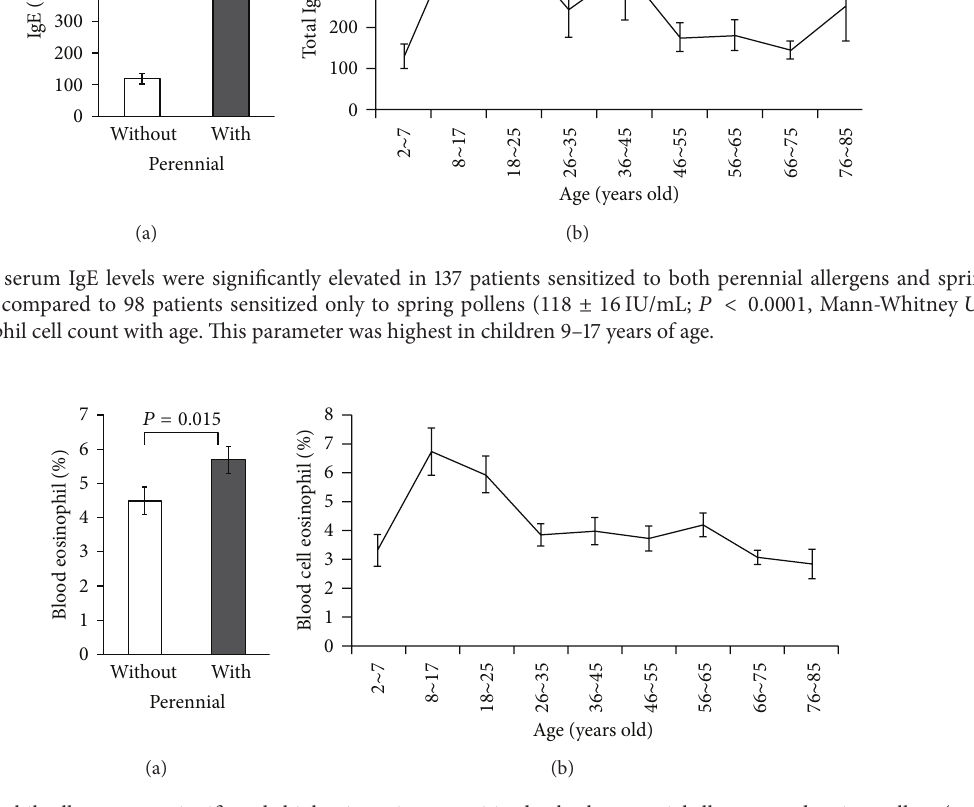
Figure 3: (a) Eosinophil cell count was significantly higher in patients sensitized to both perennial allergens and spring pollens (5.7% ± 0.4%) than in patients sensitized only to spring pollens (4.5% ± 0.4%; 𝑃 = 0.146 , Mann-Whitney 𝑈 test). (b) Variation of serum total IgE levels with age. This parameter was highest in children 9–17 years of